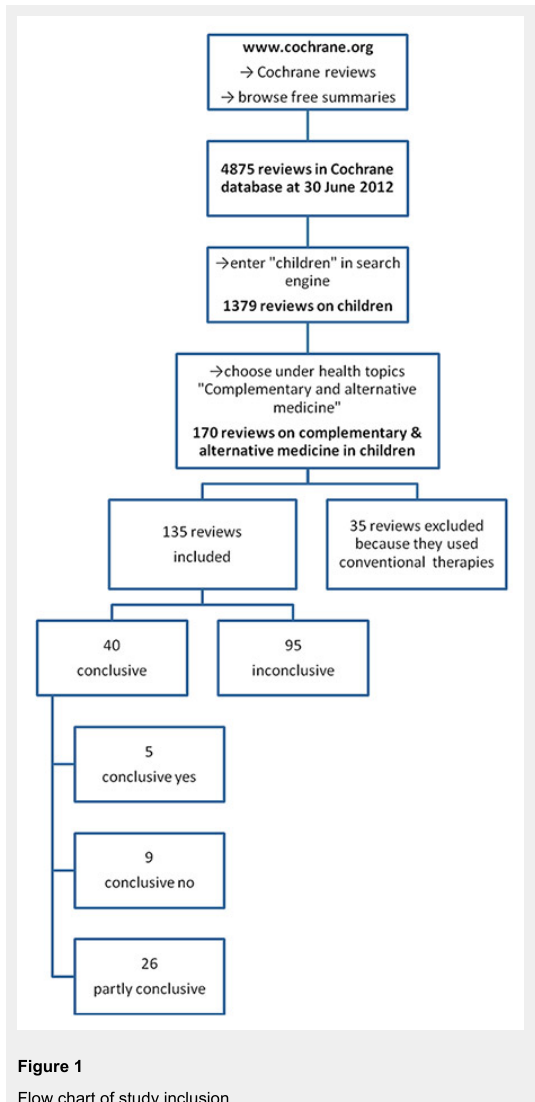
Flow chart of study inclusion.